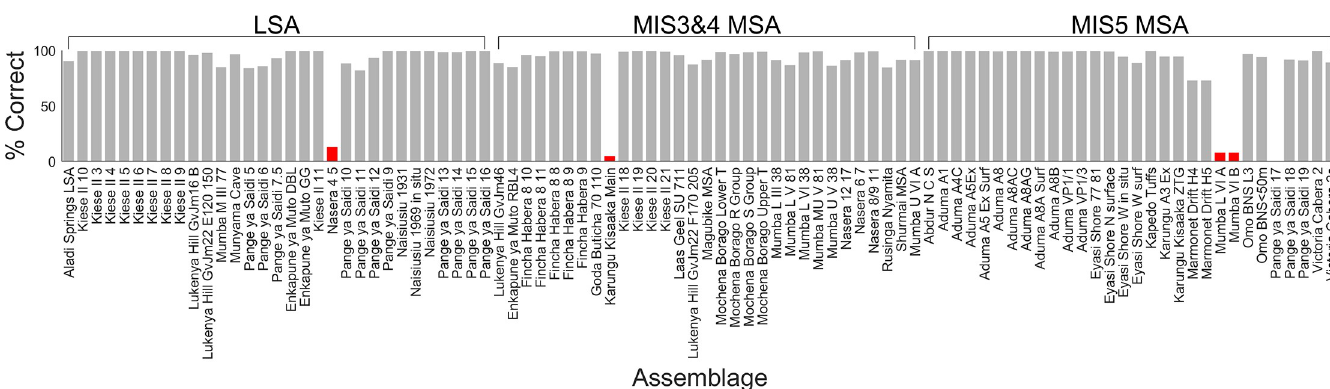
Fig 6. Percentages of correct classification (3-way). Percentages of the 1,000 networks that classify each assemblage correctly in the 3-way analysis. Red bars indicate those assemblages classified incorrectly by a weighted mean over the ensemble of networks. Note the distinction between the percentage of individual networks that classify an assemblage correctly and the overall classification of an assemblage by the weighted mean of the whole ensemble of networks.